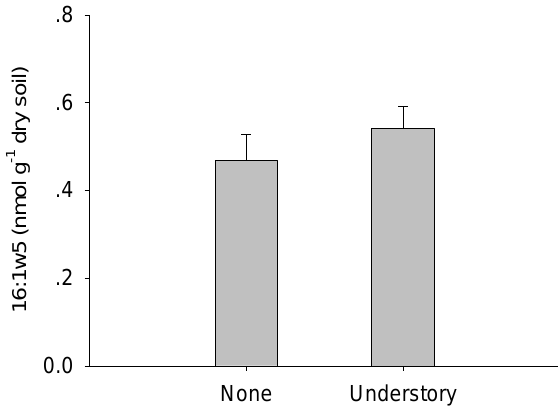
Figure A1. Contents of arbuscular mycorrhizal fungi in the different understory vegetation treatments.